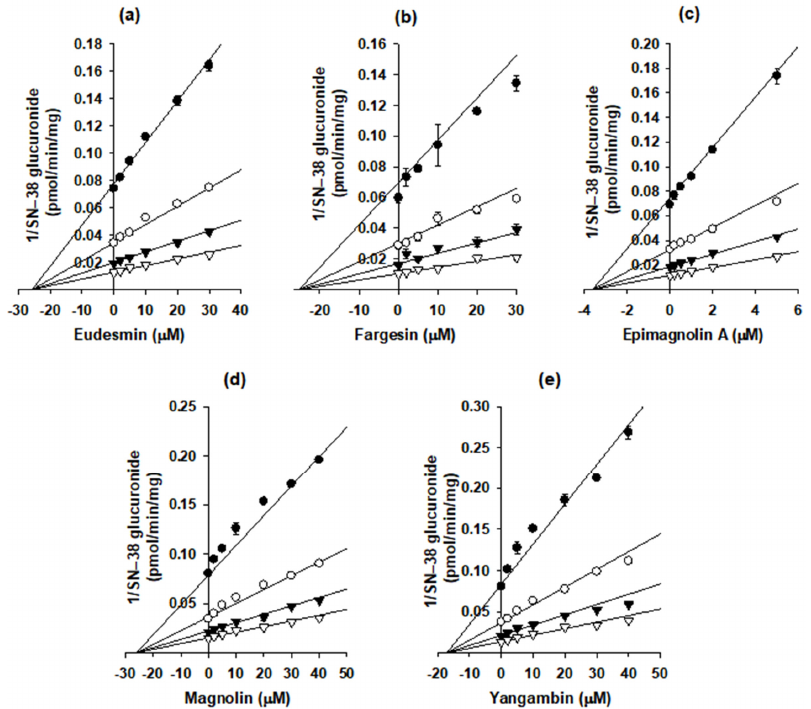
Figure 7. Dixon plots for the inhibitory effects of ( a ) eudesmin, ( b ) fargesin, ( c ) epimagnolin A, ( d ) magnolin, and ( e ) yangambin on UGT1A1-catalyzed SN-38 glucuronidation in pooled human liver microsomes. Each symbol represents the concentration of SN-38: ● , 0.2 μ M; ○ , 0.5 μ M; ▼ , 1 μ M; ▽ , 2 μ M. The data are means ± SDs ( n = 3).